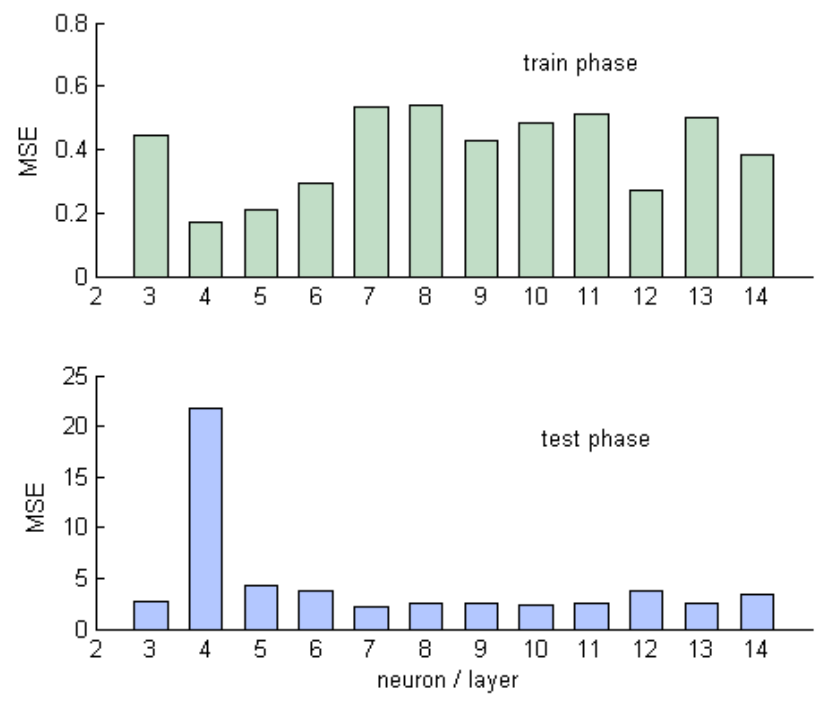
Figure 5. MSE of test and training for different